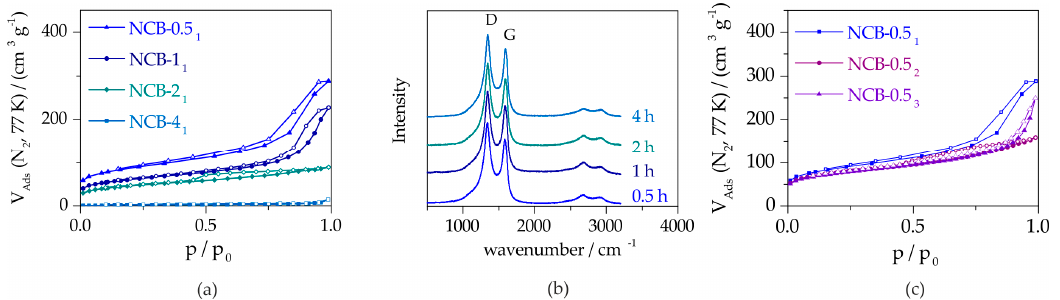
Figure 4. ( a ) Nitrogen physisorption isotherms of the NH 3 -functionalized carbon black milled with different durations and ( b ) Raman spectra; as well as ( c ) nitrogen physisorption isotherms of the NH 3 -functionalized carbon black with different volumes of NH 3 solution.